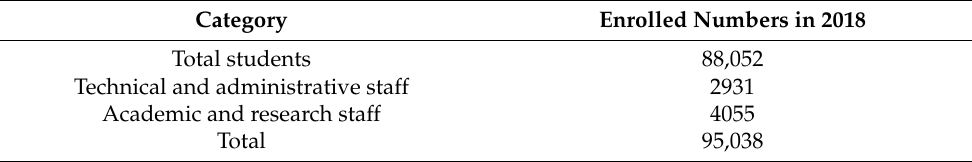
Table 13. Employees and students enrolled at the University of Bologna in 2018.